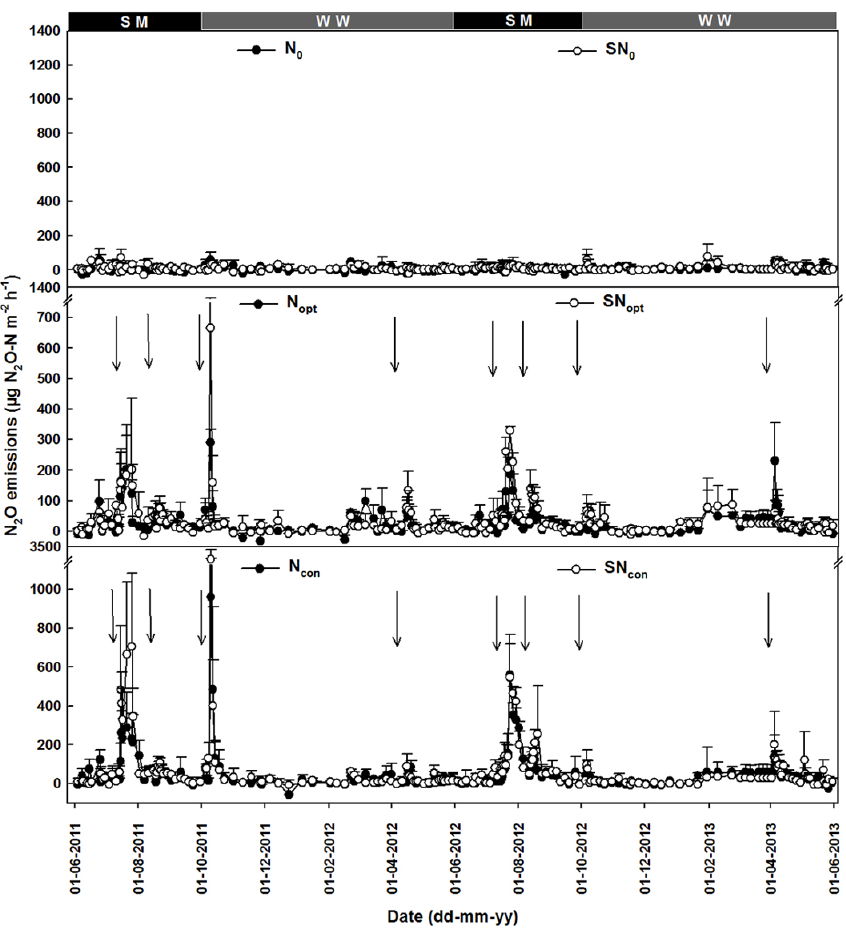
Fig. 3. Nitrous oxide (N 2 O) fluxes in the winter wheat–summer maize double-cropping system from June 2011 to June 2013. The arrows show the dates of fertilizer N